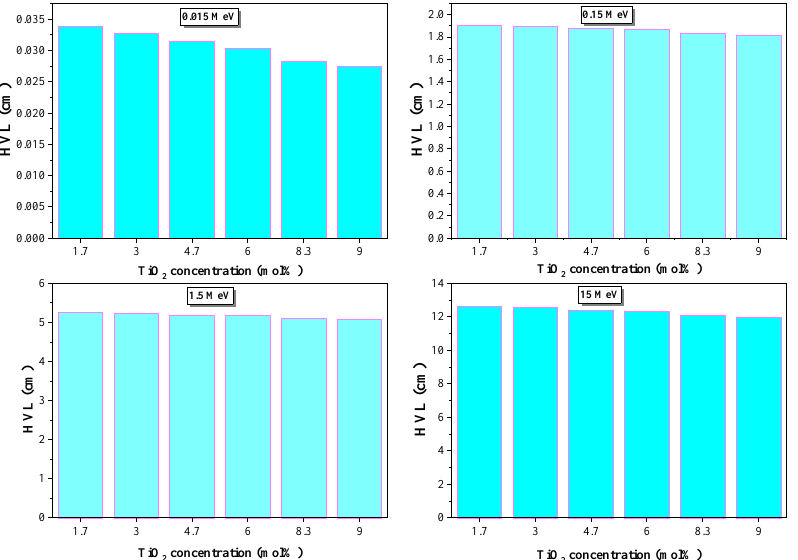
gram Phy-x/PD was used to compute the theoretical HVL values at varying incoming photon energies (0.015 – 15 MeV). As can be noted, the HVL values decreased as TiO 2 con- tent increased from 1.7 to 9 mol % at a stationary photon energy. At all selected photon energies, the lowest HVL values are achieved by S6, while the highest are observed for S1.